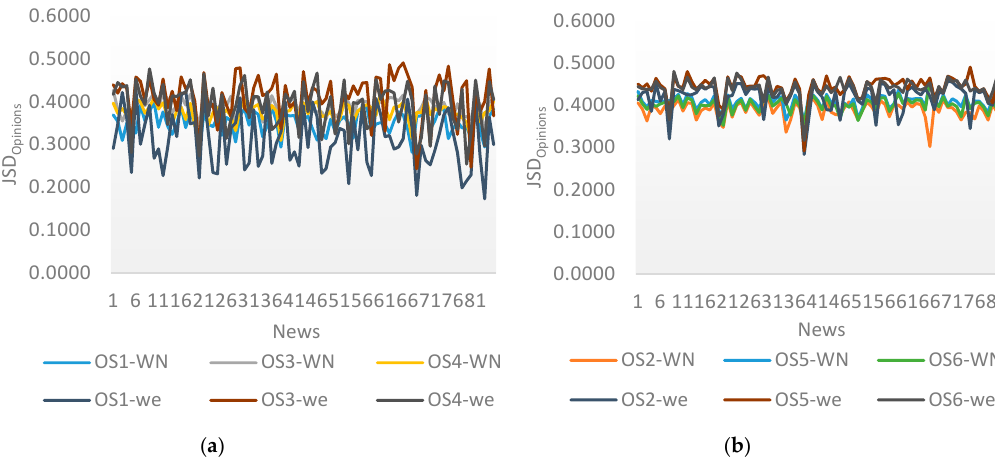
Figure 9. Results of JSD Opinions applying ( a ) term and ( b ) sentence clustering, using WordNet and word embeddings on the COVID-19 dataset.